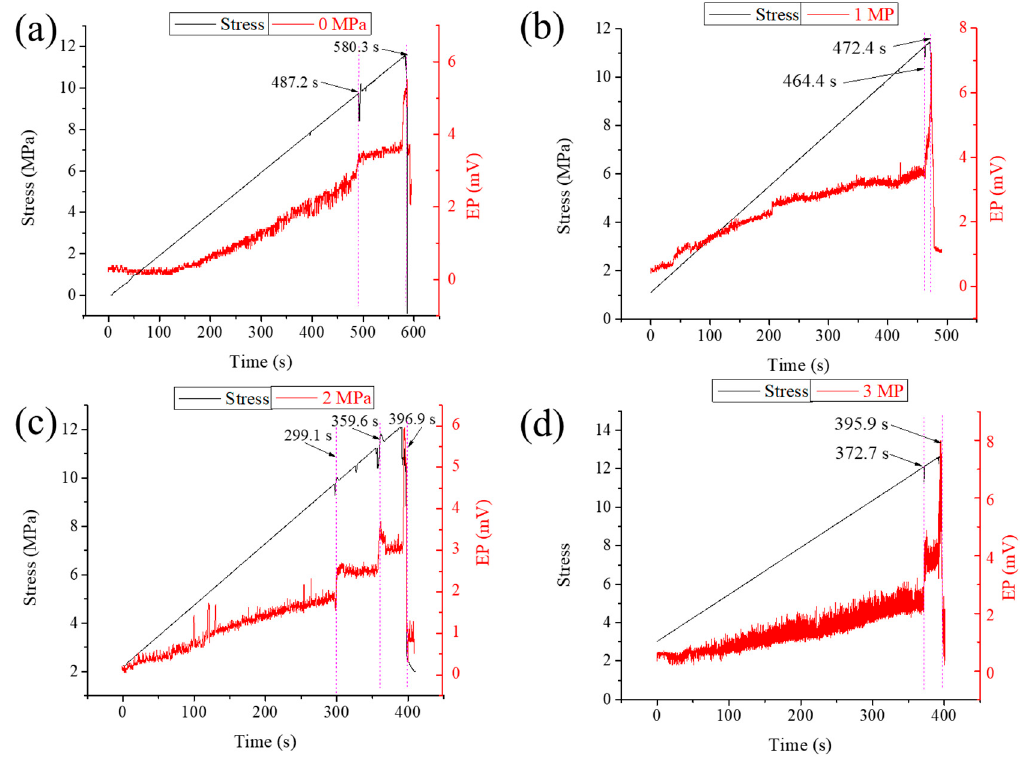
Figure 10. Changes of stress and EP during damage of coal mass under load under different gas pressures. Black and red actual lines represent the changes of stress and EP with loading time, respectively. ( a ) 0 MPa, ( b ) 1 MPa, ( c ) 2 MPa, ( d ) 3 MPa.